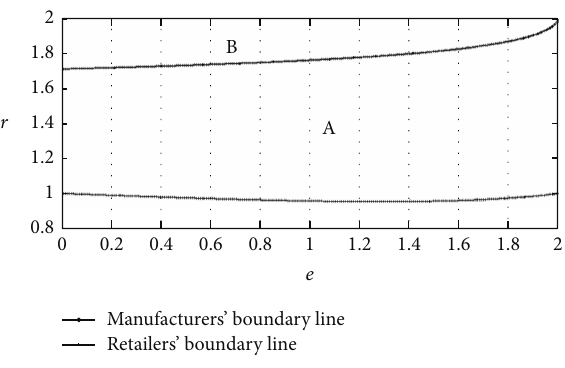
Figure 1: Information sharing